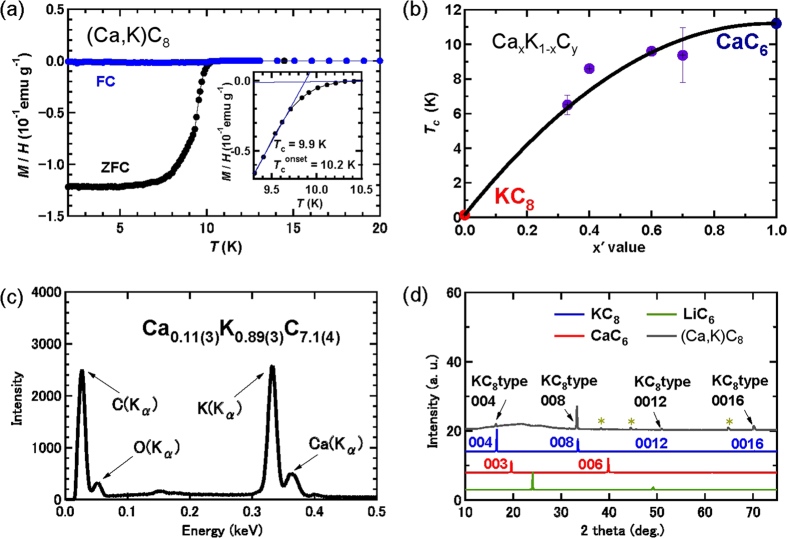
(a) M/H vs. T plots for (Ca, K)C8 (ZFC and FC modes) at ambient pressure. (b) x vs. Tc plots of CaxK1−xCy. (c) EDX spectrum of (Ca, K)C8. (d) Experimental XRD pattern of (Ca, K)C8 and simulated patterns for KC8, CaC6 and LiC6. The peaks labelled ‘*’ in the experimental XRD pattern can be assigned to the Al of the sample holder. The same sample of (Ca, K)C8 was used the to obtain the M/H − T plots shown in 1a and the XRD pattern shown in 1c, whereas the sample used for the EDX spectrum shown in 1d is different; however, the nominal x value and observed Tc are the same.